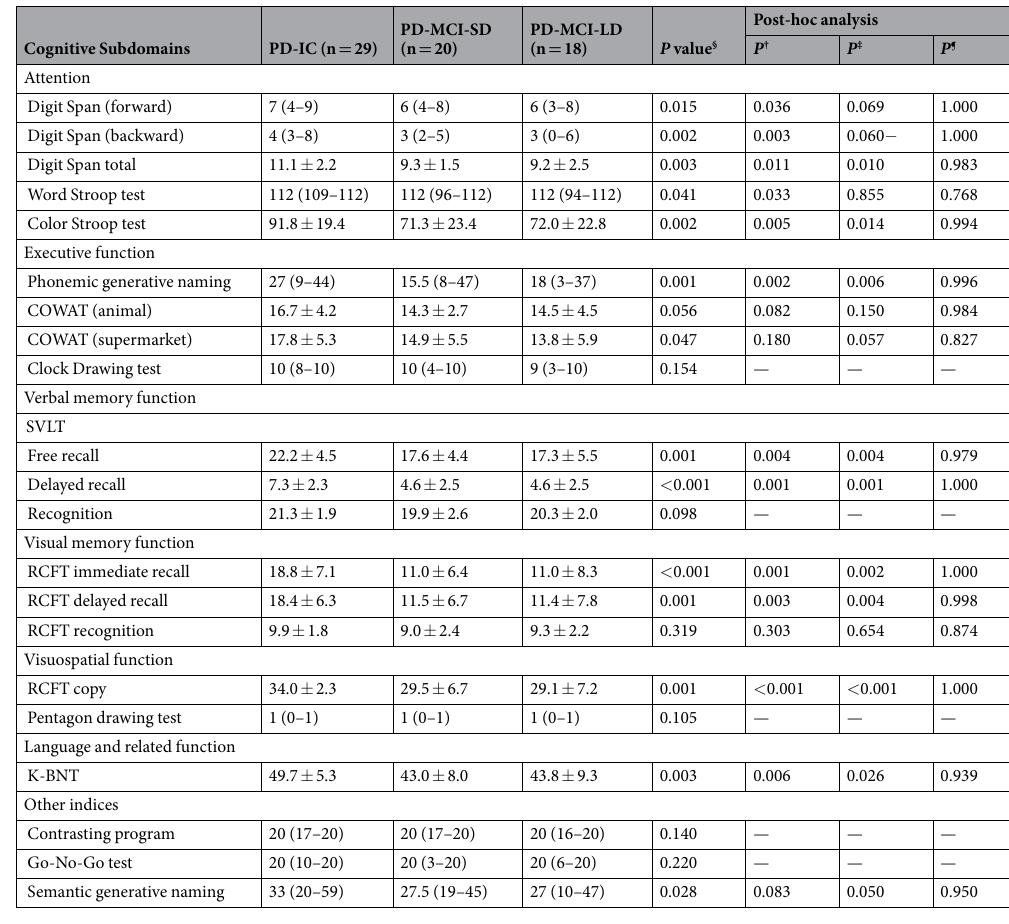
Table 2. Neuropsychological data in the PD-IC group and PD-MCI groups according to the duration of parkinsonism before MCI diagnosis. Abbreviations: MCI = mild cognitive impairment; n = number; PD-IC = Parkinson’s disease with intact cognition; PD-MCI-SD = Parkinson’s disease with a shorter duration of parkinsonism before mild cognitive impairment diagnosis; PD-MCI-LD = Parkinson’s disease with a longer duration of parkinsonism before mild cognitive impairment diagnosis; COWAT = Controlled Oral Word Association Test; SVLT = Seoul Verbal Learning Test; RCFT = Rey complex figure test; K-BNT = Korean version of the Boston Naming Test. Note.-Unless otherwise indicated, data are means ± standard deviations. § P values for comparison among the 3 groups; † P values for comparison between the PD-IC and PD-MCI-SD groups; ‡ P values for comparison between the PD-IC and PD-MCI-LD groups; ¶ P values for comparison between the PD-MCI-SD and PD-MCI-LD groups.